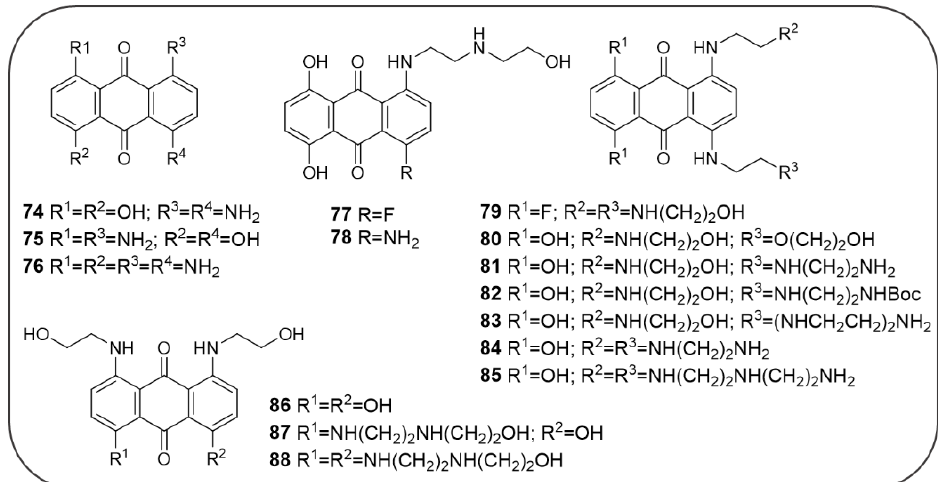
Figure 16. Yang et al. MTX analogues.